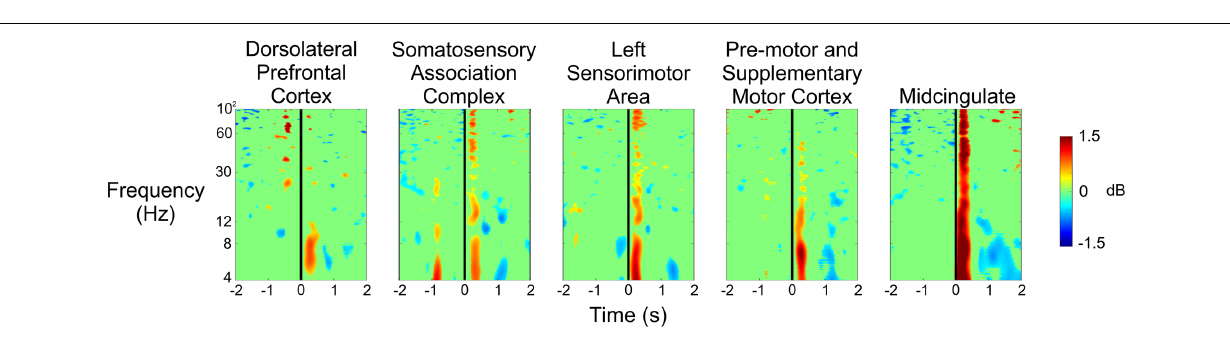
FIGURE 6 | Event-related spectral perturbation plots showing the changes in power associated with the experimenter’s trigger pull (vertical black line) during the Stress condition for all five independent